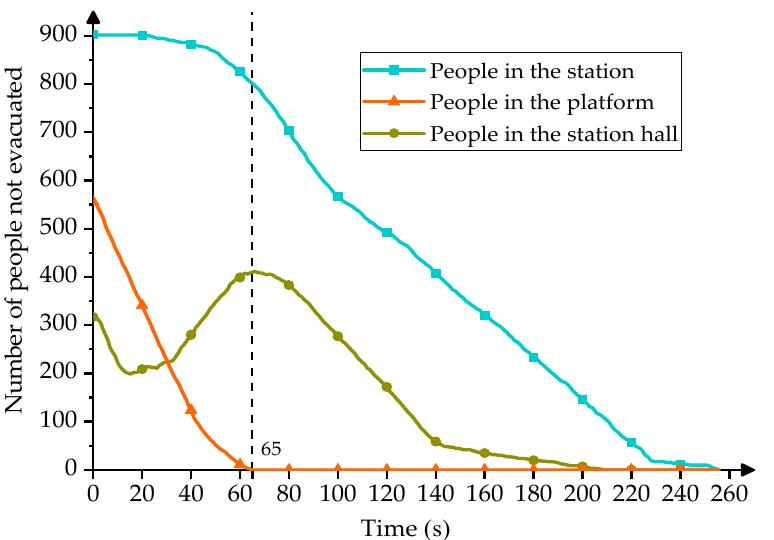
Figure 16. Comparative analysis of the number of people not evacuated from the fire at the end of the platform.